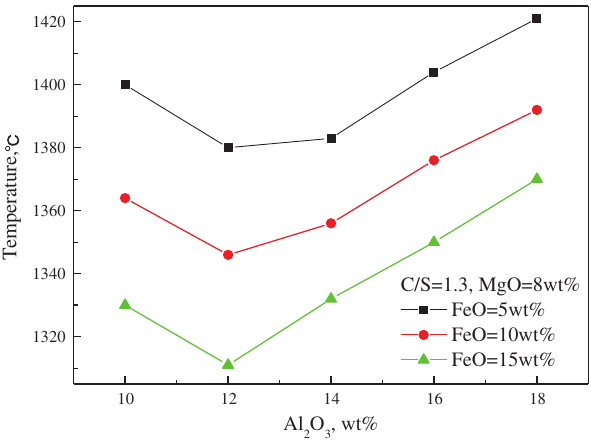
Figure 11: T LQ of CaO – SiO 2 – Al 2 O 3 – MgO – FeO system as a function of the FeO and Al 2 O 3 at 8 wt% MgO and C/S at